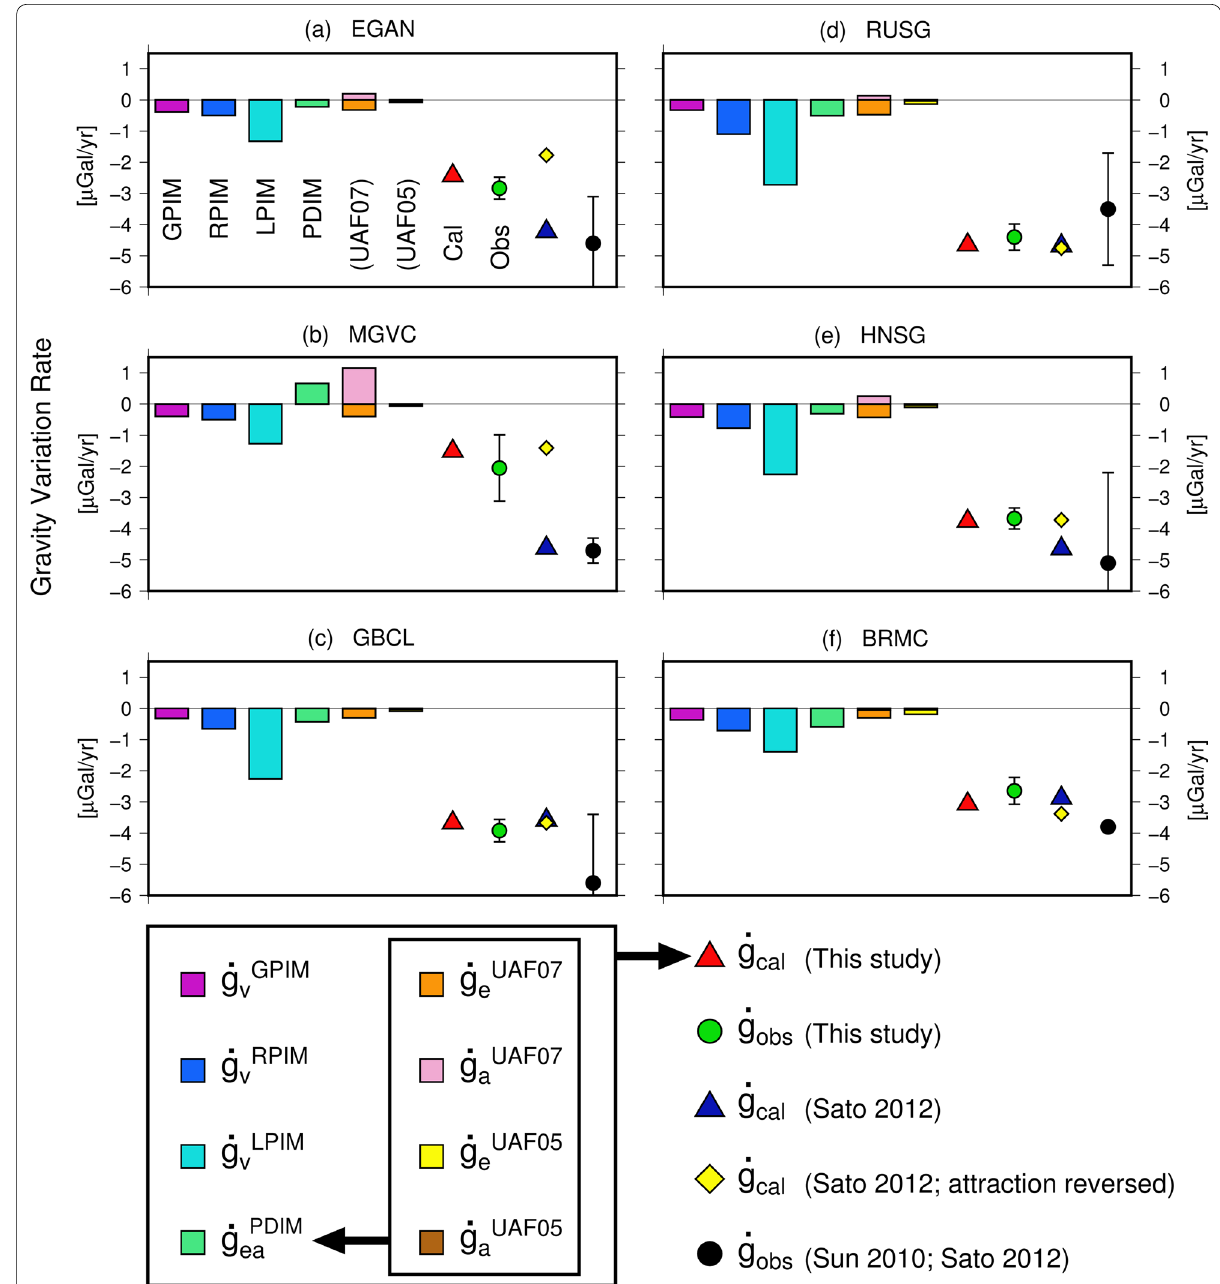
Fig. 9 Gravity variation rates at six AG points. Purple, blue, cyan, and green bars indicate the calculated gravity variation rates associated with GPIM, RPIM, LPIM, and PDIM, respectively. Orange, pink, yellow, and brown bars indicate the four components of the PDIM-derived gravity change (green bars), i.e., the orange/pink bars indicate the loading/attraction effects calculated from the UAF07’s PDIM model, and the yellow/brown bars indicate the loading/attraction effects calculated from the UAF05’s PDIM model. Red triangles and green circles indicate the gravity variation rates calculated from our GIA model and determined from our AG measurement, respectively. Blue triangles and black circles indicate the gravity variation rates calculated and observed by the earlier studies (Sun et al. 2010; Sato et al. 2012), respectively. Yellow diamonds indicate the gravity variation rates obtained by reversing the sign of the attraction effect for the rate calculated by Sato et al.